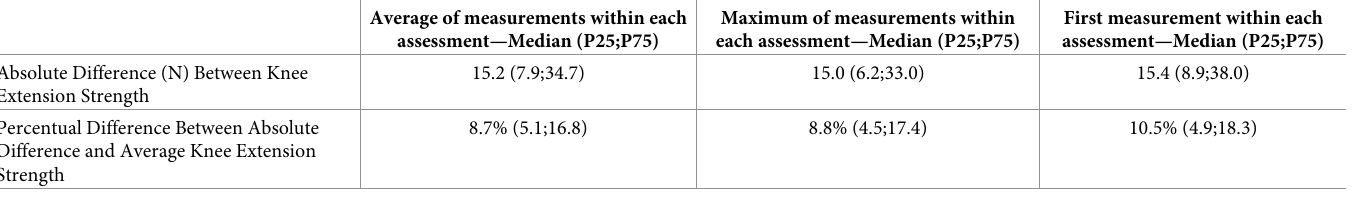
Table 3. Absolute difference (in Newton) of knee extension strength and percentual difference of absolute difference over average muscle strength of all assessments with Hand Held Dynamometer (HHD) using mean, maximum and first measurements between assessments AB and CD for the same observer. Average of measurements within each Maximum of measurements within First measurement within each assessment—Median (P25;P75) each assessment—Median (P25;P75) assessment—Median (P25;P75) Absolute Difference (N) Between Knee Extension